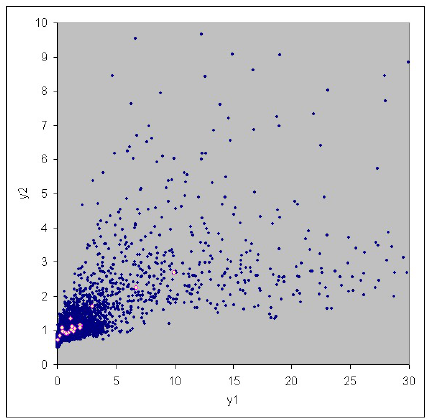
Figure 4. Simulation scatterplot of ˆ g ( y 1 , y 2 ) , m = 15. Large scale.